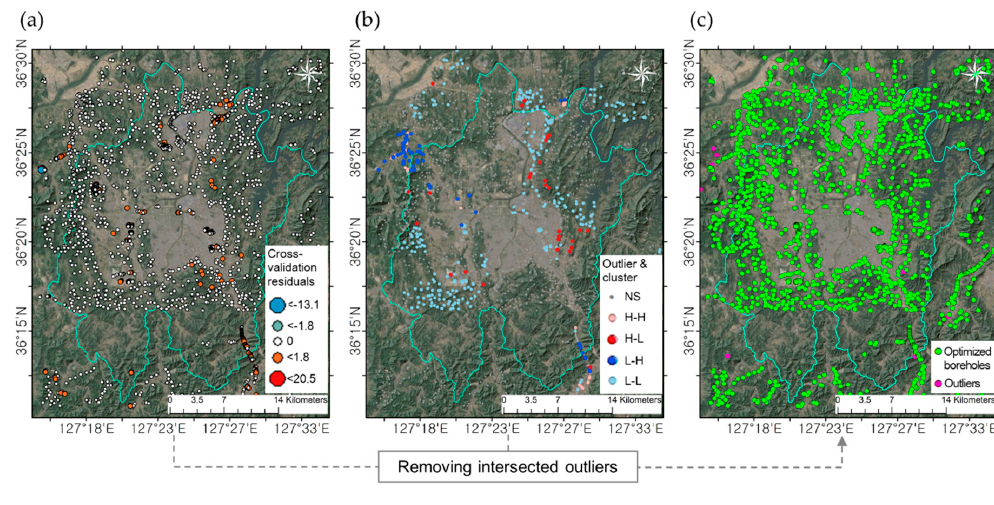
Figure 4. Outlier detection of bedrock depth data in the borehole dataset based on ( a ) the cross- validation-based method, ( b ) Anselin Local Moran’s I statistic-based method, and ( c ) outliers detected by both methods, applied to bedrock depth. Outlier and clusters classified by Anselin Local